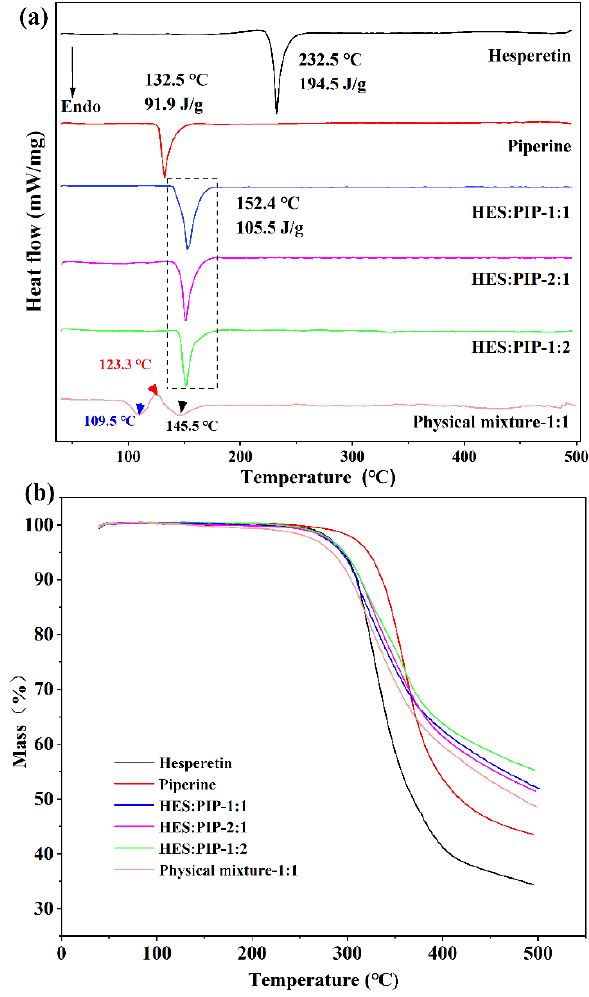
Figure 2. DSC ( a ) and TG ( b ) curves of HES–PIP system.